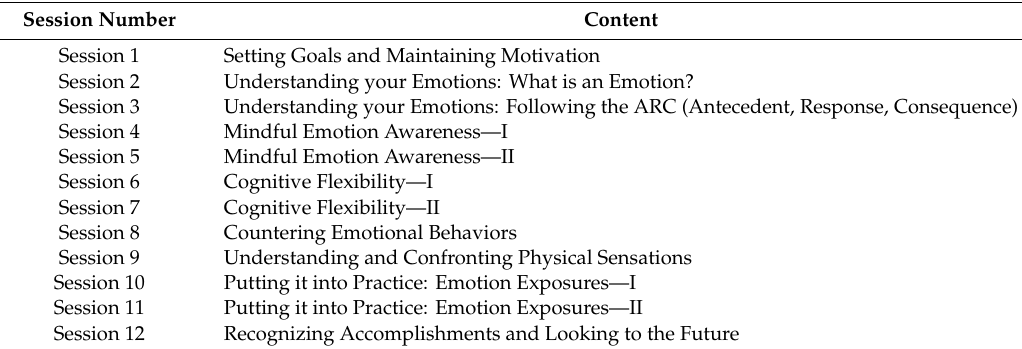
Table 2. Treatment content split by